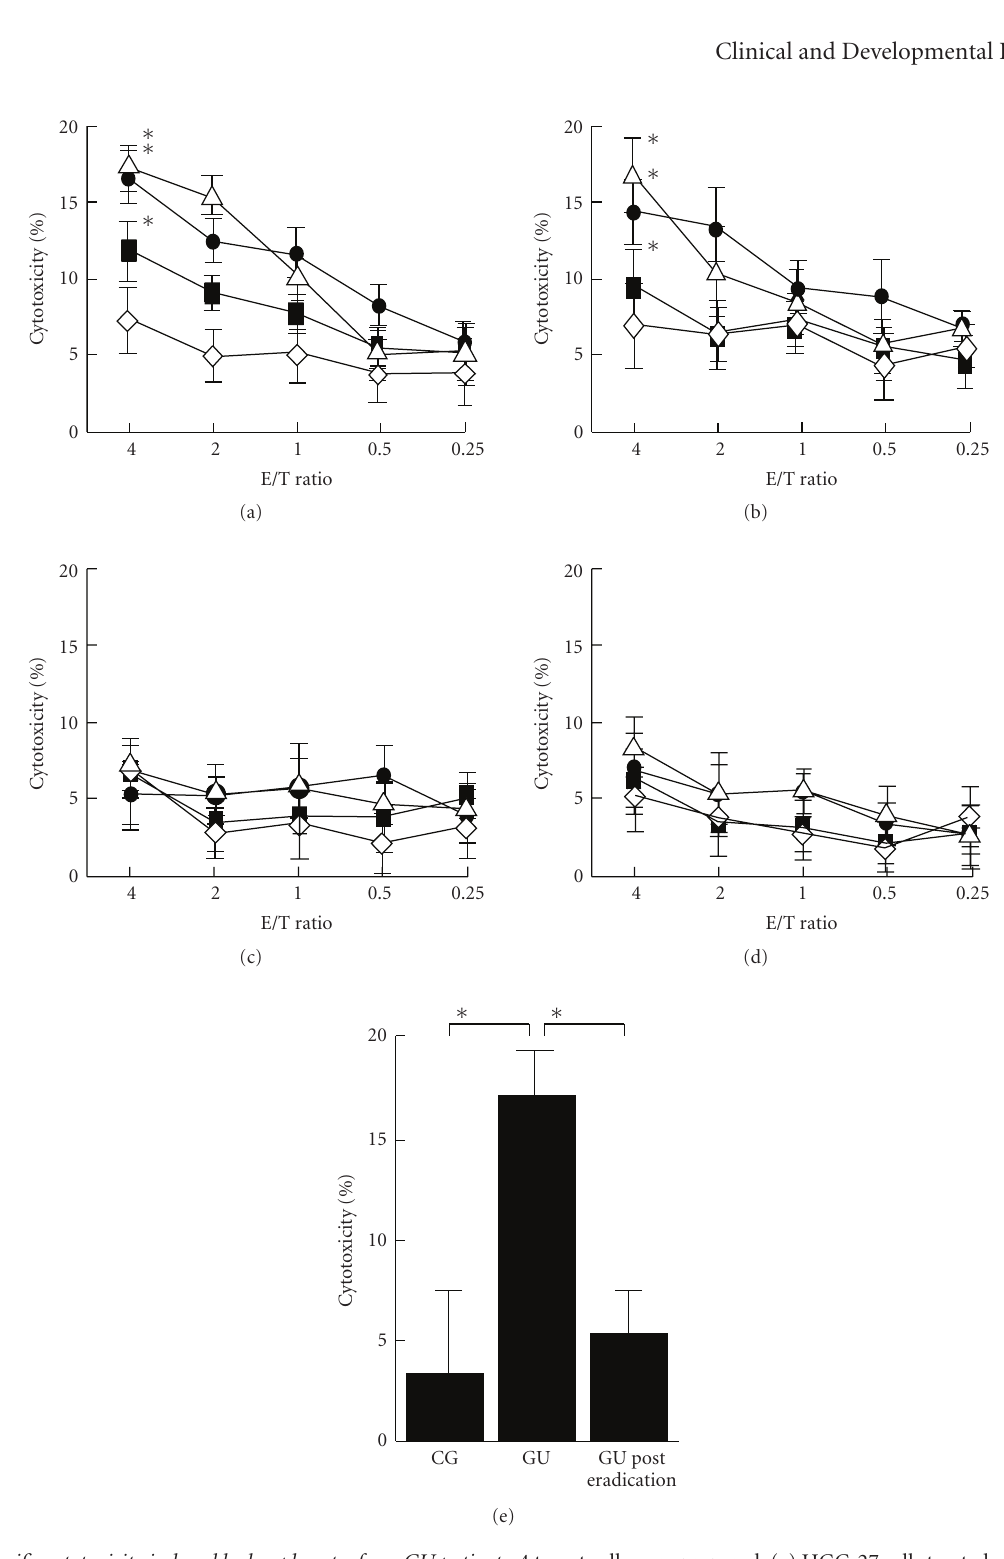
Figure 3: Specific cytotoxicity induced by lymphocytes from GU patients. 4 target cells were prepared. (a) HGC-27 cells treated with heat stress and patients’ sera, (b) HGC-27 cells treated with heat stress, (c) HGC-27 cells treated with patients’ sera, (d) nontreated HGC-27 cells. PBMCs were taken from GU patients ( n = 8). PBMCs stimulated with conA and H. pylori ( (cid:2) ) in addition to IL-12 ( (cid:3) ) or IL-4 ( • ) were used as e ff ector cells. Nonstimulated PBMCs ( ♦ ) were also used as a control. Both cells reacted with various E/T ratios. An E/T ratio dependent cytotoxicity was observed only against heat-stressed HGC-27 cells or heat-stressed and sera-treated HGC-27 cells. The cytotoxicities of e ff ector cells stimulated by H. pylori lysate were significantly enhanced, regardless of additional cytokine stimulations ( ∗ ; P < . 05). (e) The comparison of cytotoxicities among lymphocytes from CG, GU, and GU posteradication patients. Target cells were HGC-27 cells treated with heat stress and patients’ sera. E ff ector cells were PBMCs stimulated with conA, H. pylori , and IL-12. The E/T ratio was 4. Specific cytotoxicity was only observed in GU patients’